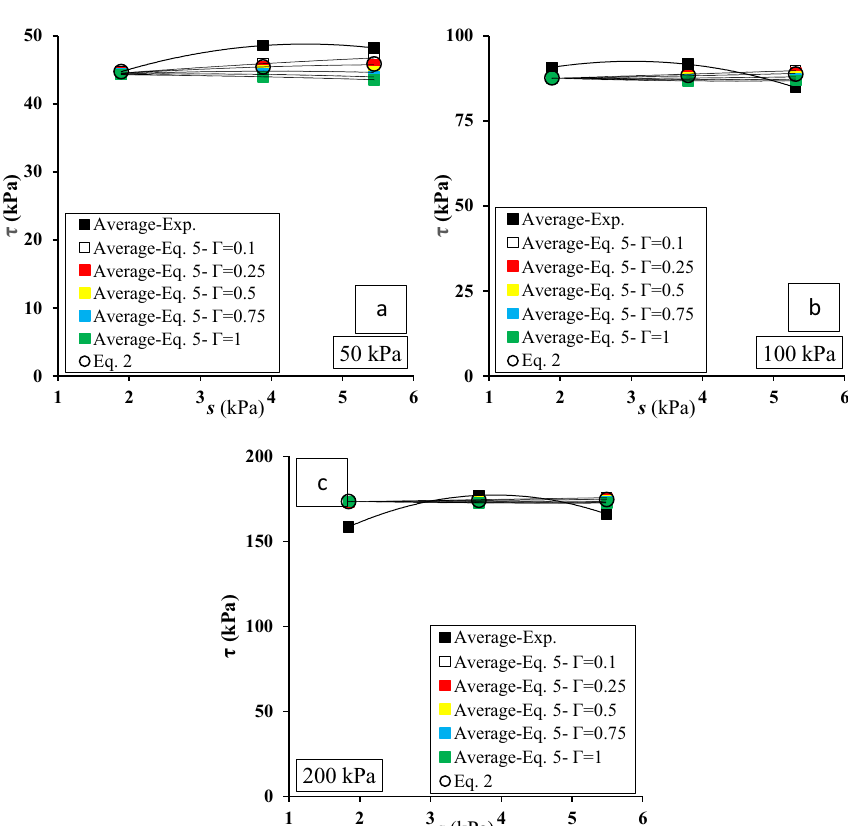
Fig. 6 Evaluation of the effective degree of saturation for the direct shear results for sand 2 at ( a ) σ ( b ) σ 100 kPa and ( c ) σ 200 = =